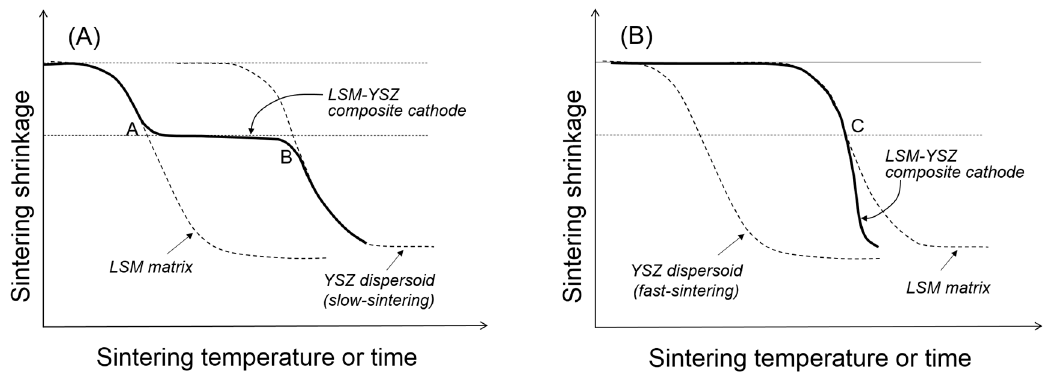
Figure 4. Sintering behavior of LSM-YSZ composite with ( A ) slow- and ( B ) fast-sintering YSZ particles dispersed in LSM matrix under free sintering condition.